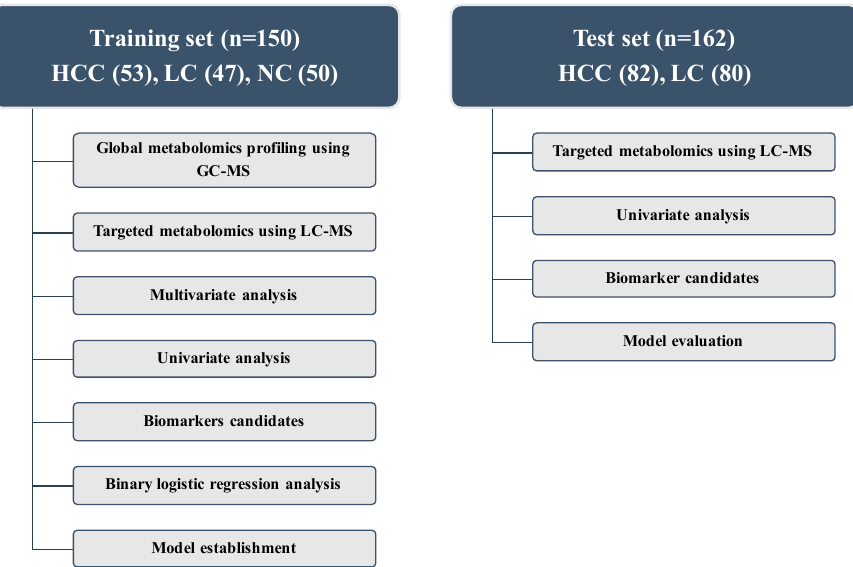
Figure 1. Design of the study and description of the training and test sets. HCC, hepatocellular carcinoma; LC, liver cirrhosis; NC, normal control; LC-MS, liquid chromatography-mass spectrometry; GC-MS, gas chromatography-mass spectrometry.